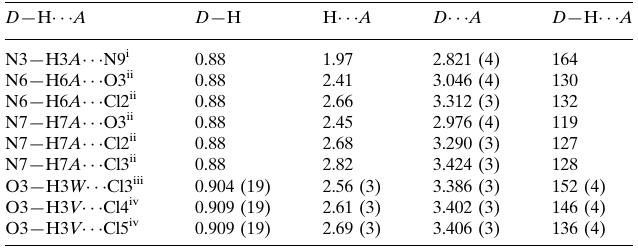
Hydrogen-bond geometry (A˚ , (cid:4)